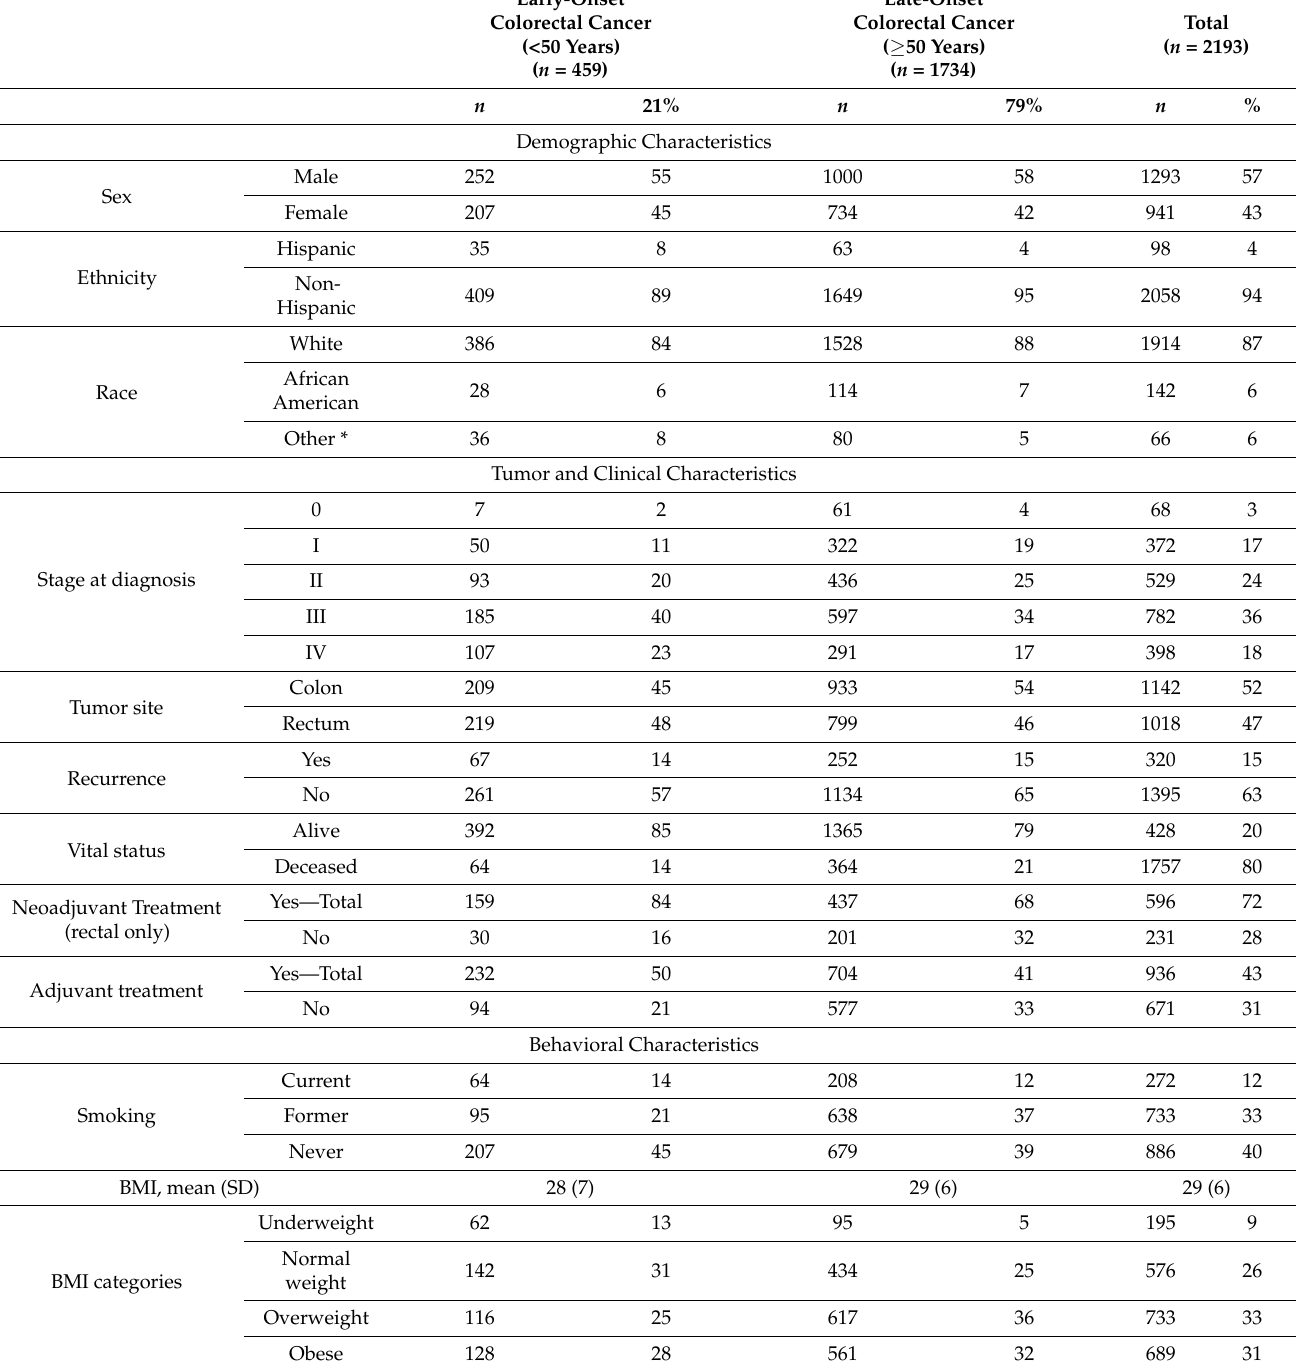
Late-Onset Colorectal Cancer Total ( ≥ 50 Years) ( n = 2193) ( n = 1734)